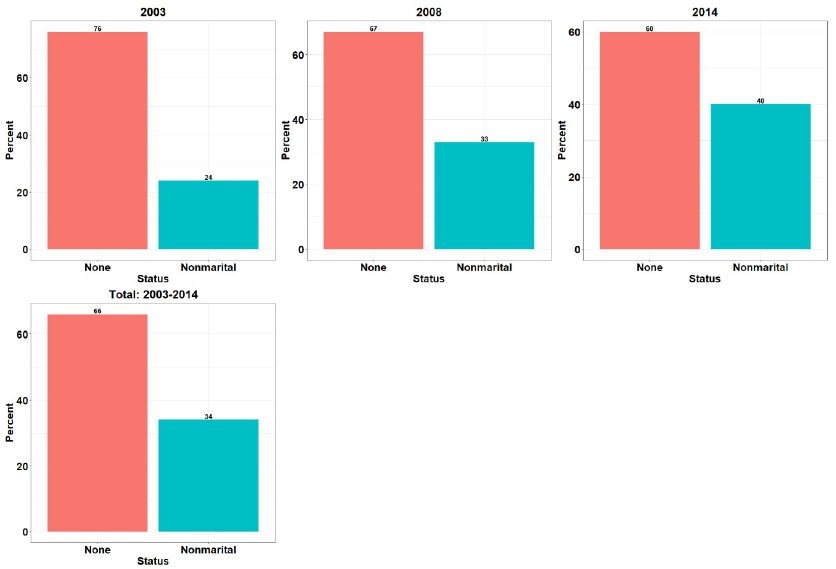
Fig 1. Levels of nonmarital fertility in Ghana: GDHS